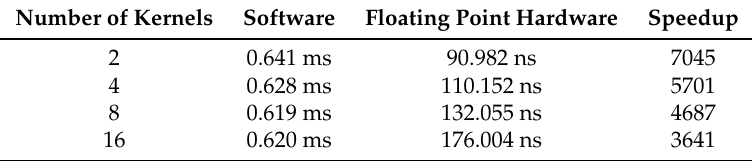
Table 8. Execution time, ts , of the Iris dataset—floating point.